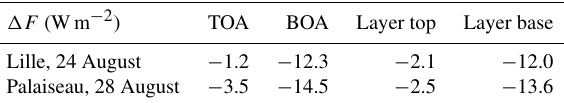
Table 4. Daily averaged net DRF flux calculated by GAR- RLiC/GRASP. Aerosol microphysical properties in Table 3 and aerosol vertical distributions in Figs. 9a and 10a are used to cal- culate the DRF effect at the following four vertical